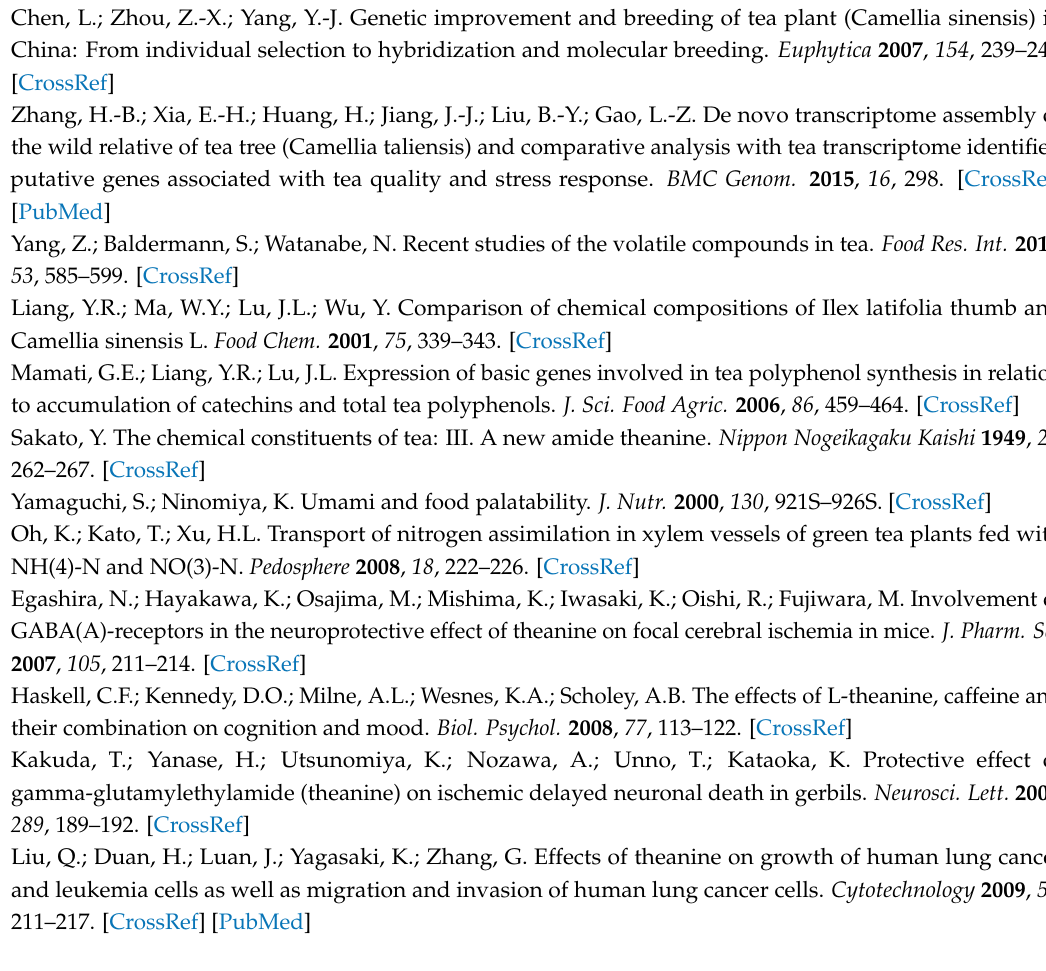
Supplementary Materials: Supplementary Figure S1: Multiple alignment of the protein sequence of pCsAlaDC with the characterized SDCs from other